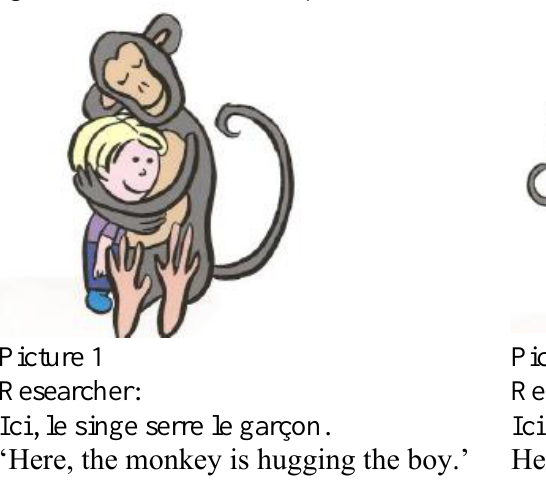
Figure 1. A standard cleft experimental